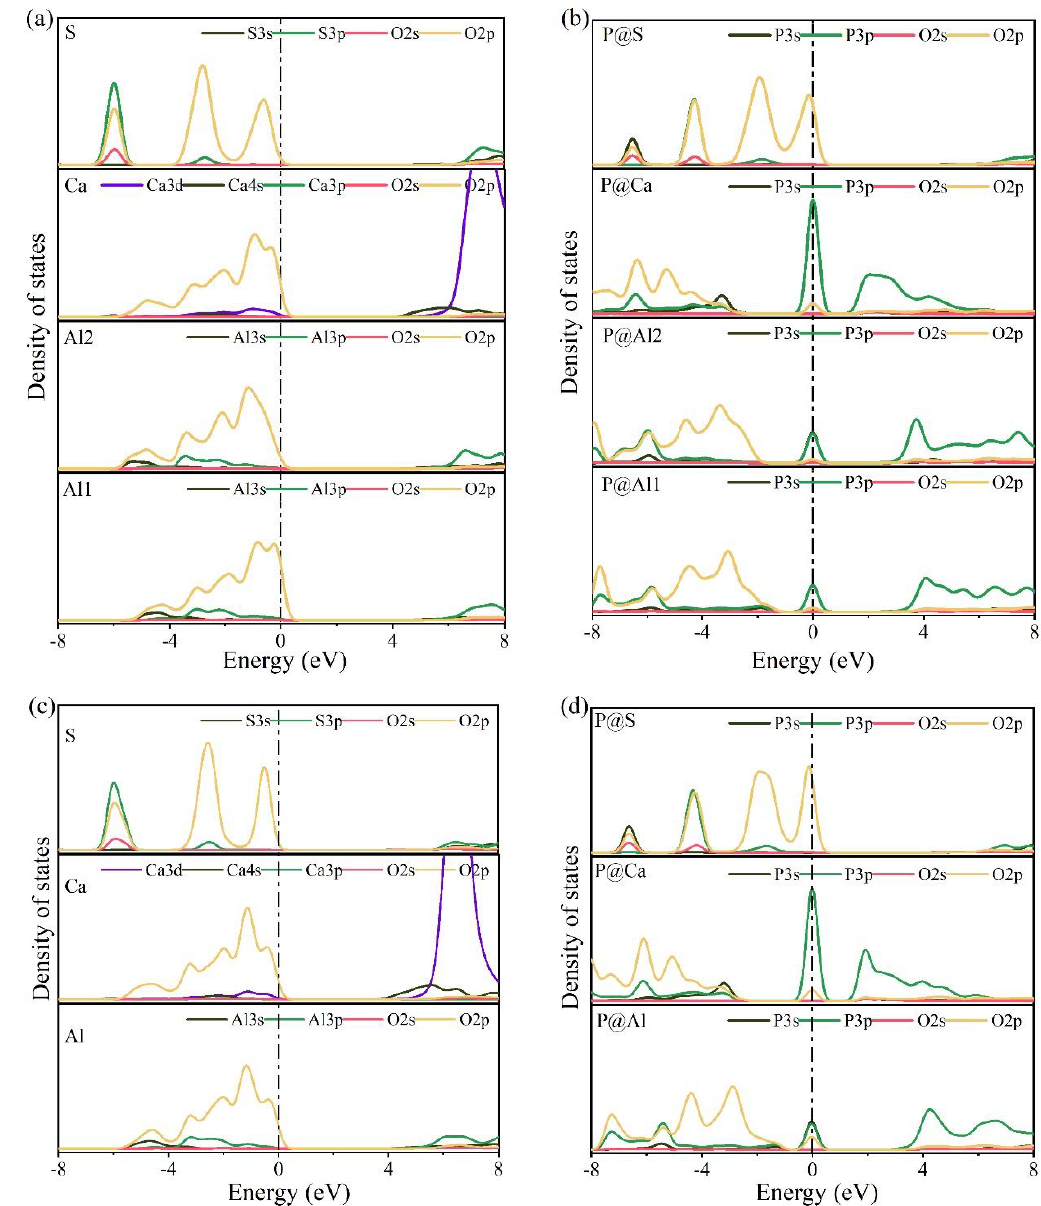
Figure 10. Calculation results of PDOS for different elements in the configurations of pure and P-doped ye’elimite (position of the Fermi energy level (0 eV) is indicated by a dotted line), ( a ) pure orthorhombic system (ST), ( b ) P@ST, ( c ) pure cubic system (SS), and ( d ) P@SS.